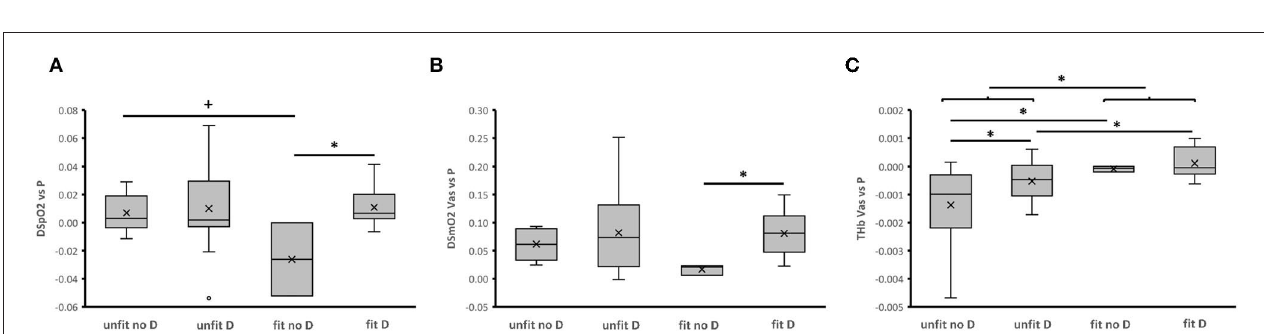
FIGURE 4 | ACE-I/D genotype and aerobic fitness associated differences in power-related linear relationships of aerobic metabolism during pedaling. (A–J) Box-Whisker plots for the slope of linear relationships between parameters of the pathway of oxygen and power output during the work phase of the ramp exercise test. Box, first and third quartile; central line, median; x, mean; whisker, minima-maxima. * p < 0.05 for the indicated comparison. ANOVA with post-hoc test of Fisher. + ,*,**Indicate p < 0.10, < 0.05 and < 0.001, respectively, for the indicated comparison. Swung brackets refer to data from a same fitness state. ANOVA with post-hoc test of least significant difference.